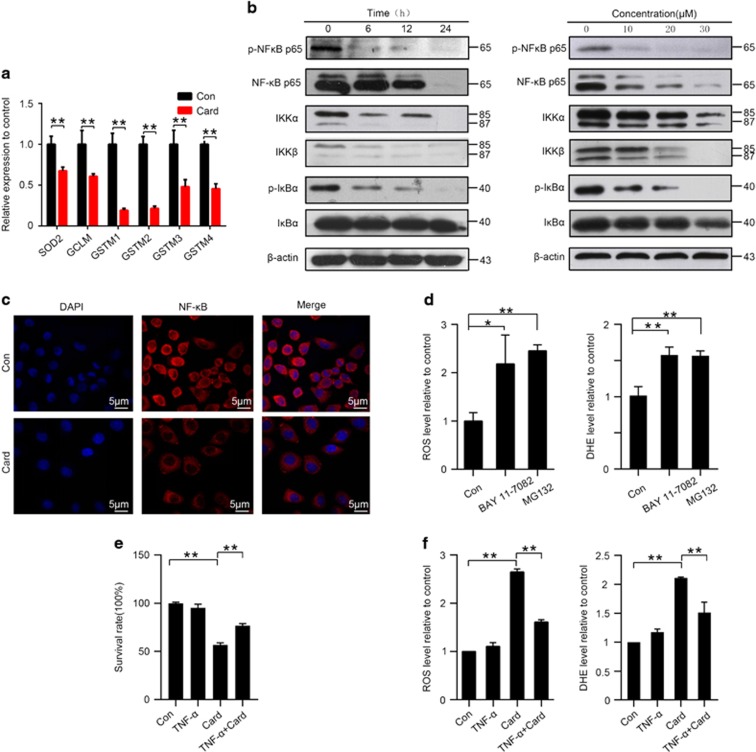
Cardamonin-induced accumulation of ROS is mediated through the inhibition of the NF-κB pathway. (a) Expression of SOD2, GCLM, GSTM1, GSTM2, GSTM3 and GSTM4 were measured by real-time PCR after treatment with 20 μM of cardamonin for 4 h. **P<0.01, n=3. (b) After treatment with cardamonin for the indicated concentrations or indicated time, expression of p-NF-κB, NF-κB, IKKα, IKKβ, p-IκB and IκB were evaluated by western blotting. (c) CNE-2 cells were cultured with 20 μM cardamonin or 0.1% DMSO for 12 h and then the intracellular distribution of NF-κB was analyzed by immunofluorescence. (d) After treatment with NF-κB inhibitors in the present of cardamonin, intracellular ROS levels were measured using DCFH-DA and DHE, **P<0.01, n=3. (e) CNE-2 cells were treated with 20 μM cardamonin with or without TNF-α cell viability was measured. **P<0.01, n=3. (f) After treatment with NF-κB activator TNF-α in the presence of cardamonin, intracellular ROS levels were measured using DCFH-DA and DHE **P<0.01, n=3